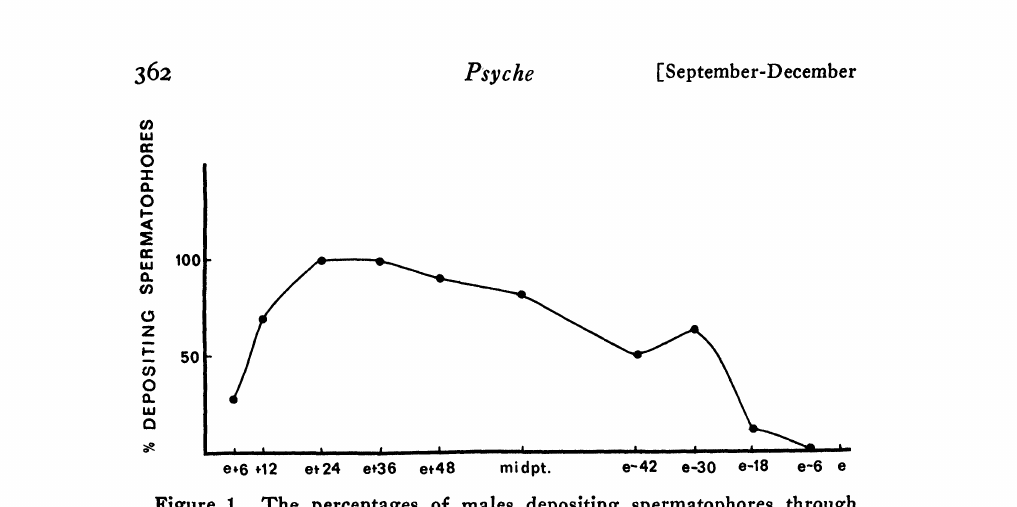
Figure 1. The percentages of males depositing spermatophores through the reproductive instars. Ages are given in hours relative to ecdyses (e) at the onset and conclusion of the